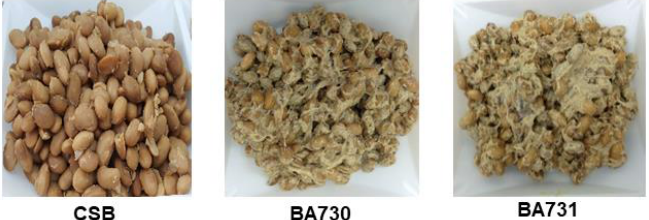
Figure 1. Photo of cooked soybeans (CSB), chungkookjang made with B. amyloliquefaciens SRCM100730 (BA730), chungkookjang made with B. amyloliquefaciens SRCM100731